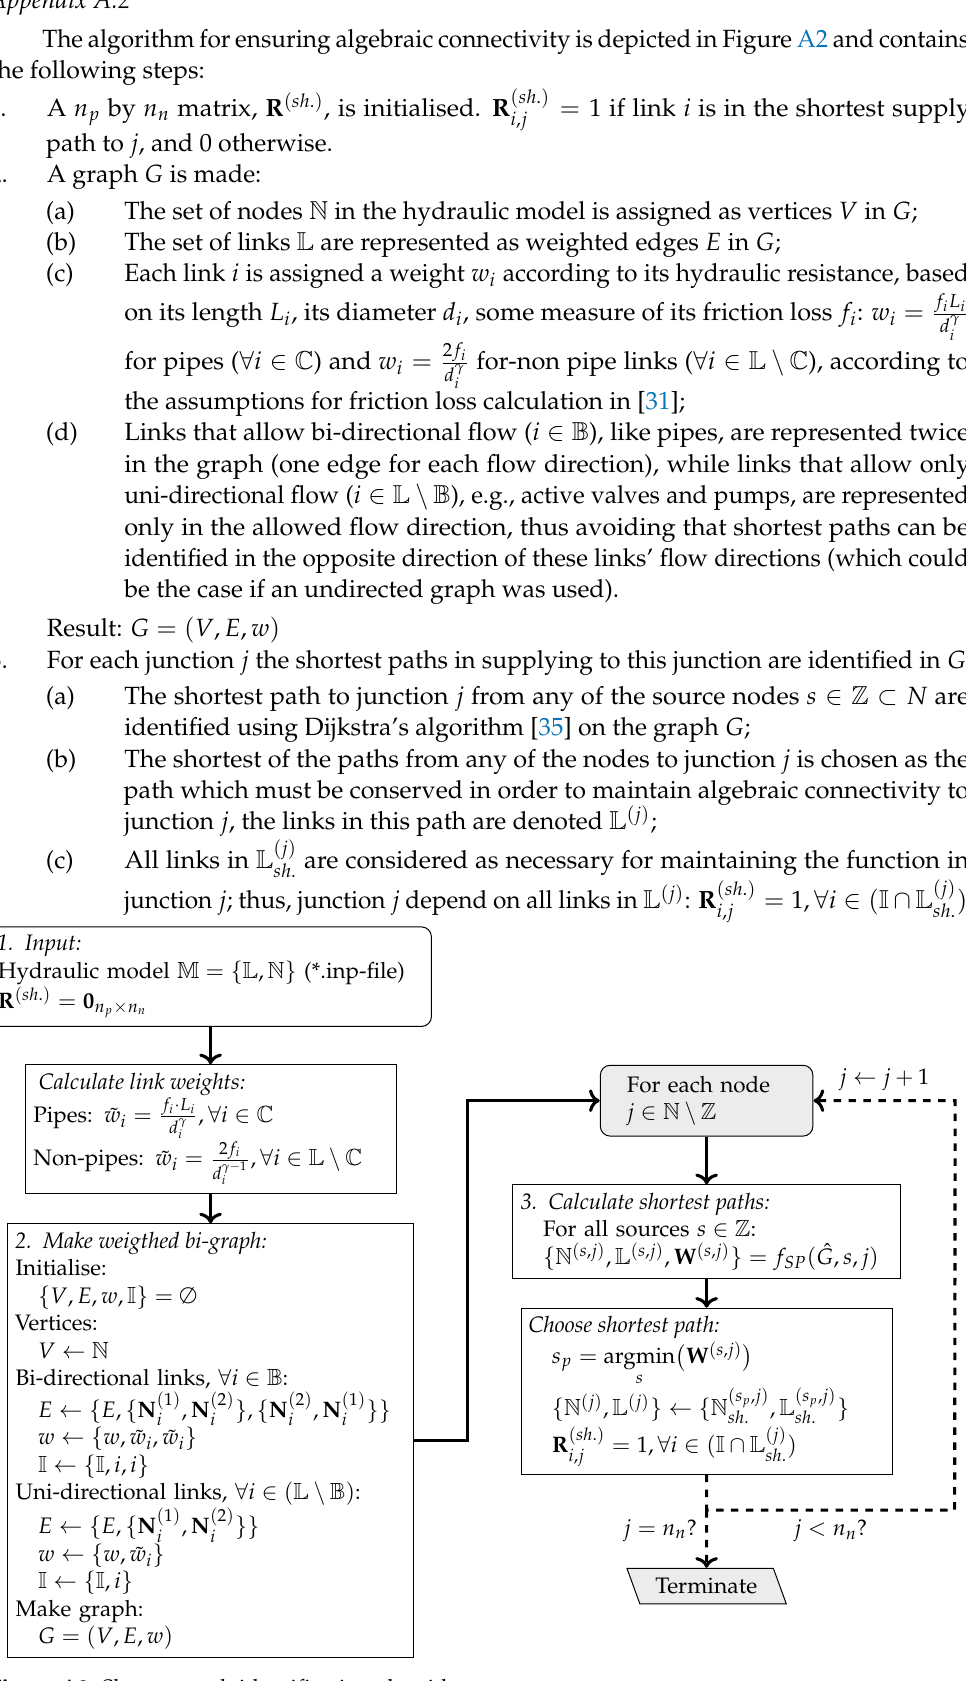
Figure A2. Shortest path identification